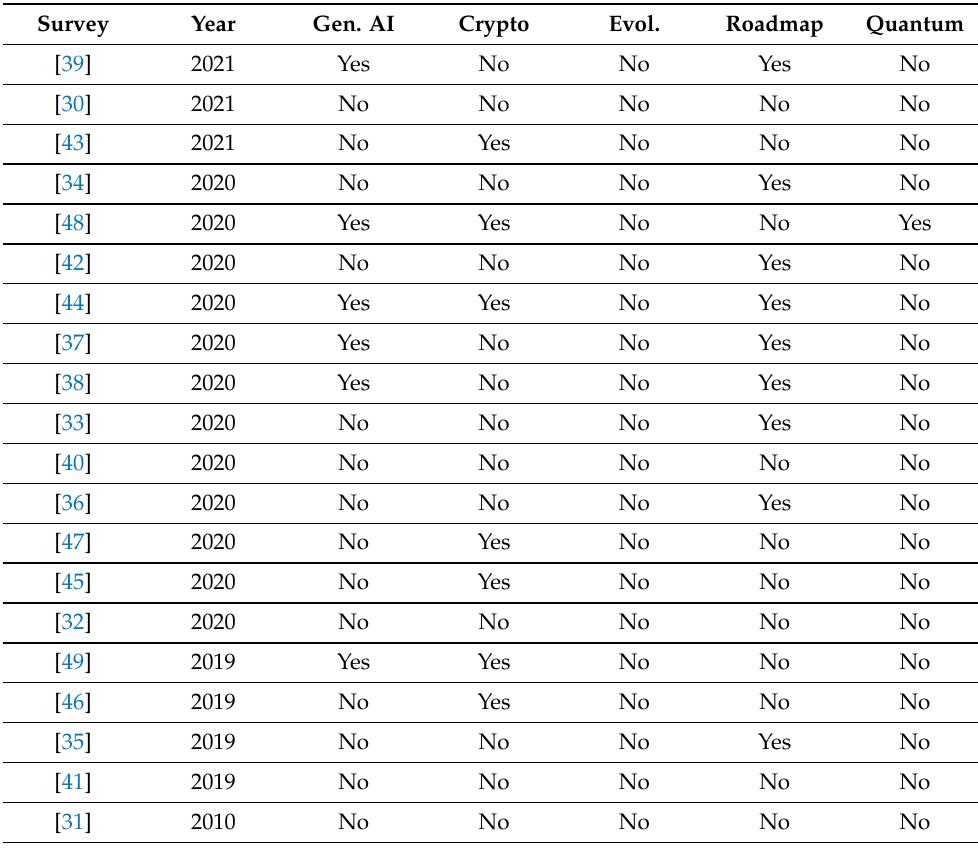
Table 2. Summary of Existing Surveys.